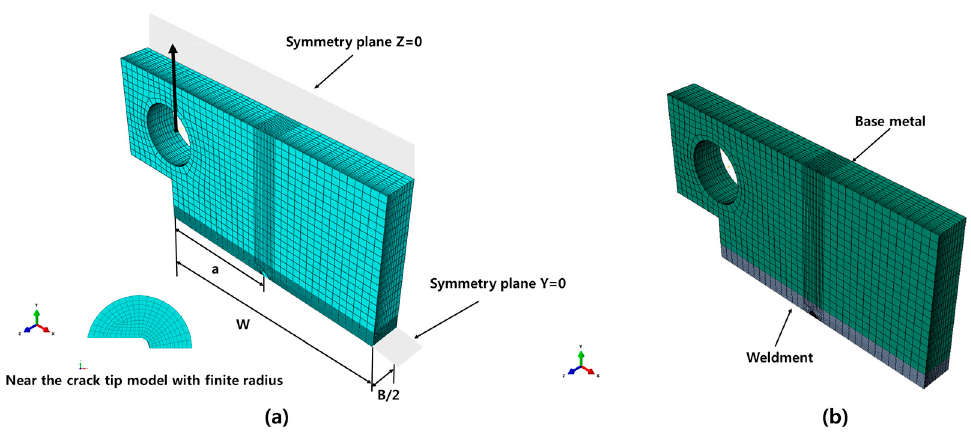
Figure 5. ( a ) Finite element model for the CT specimen; ( b ) assignment of the material properties (a/W = 0.5).